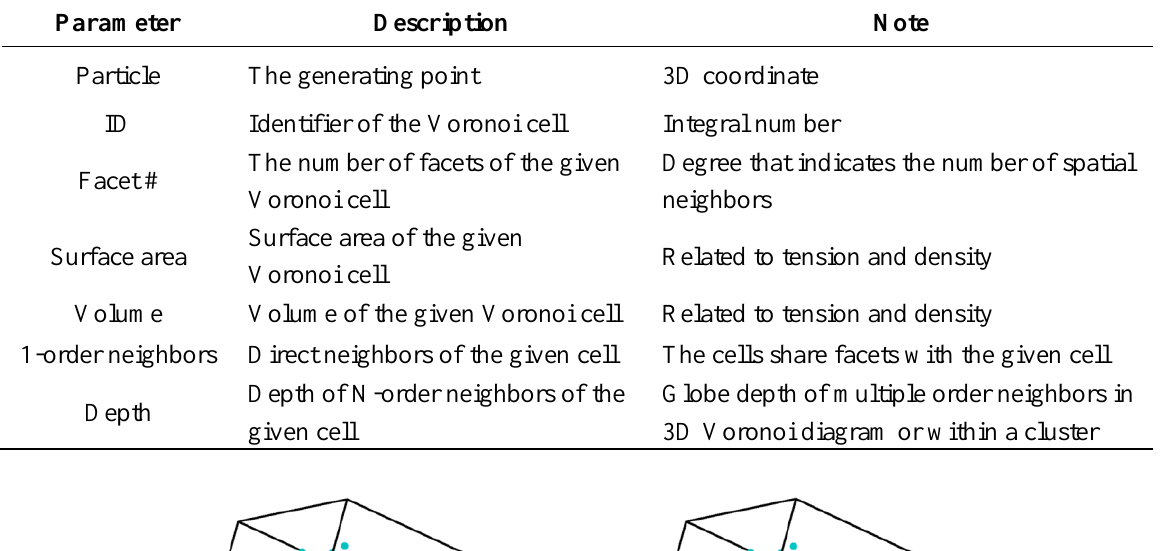
Table 1. Description of the 3D Voronoi cell parameters.